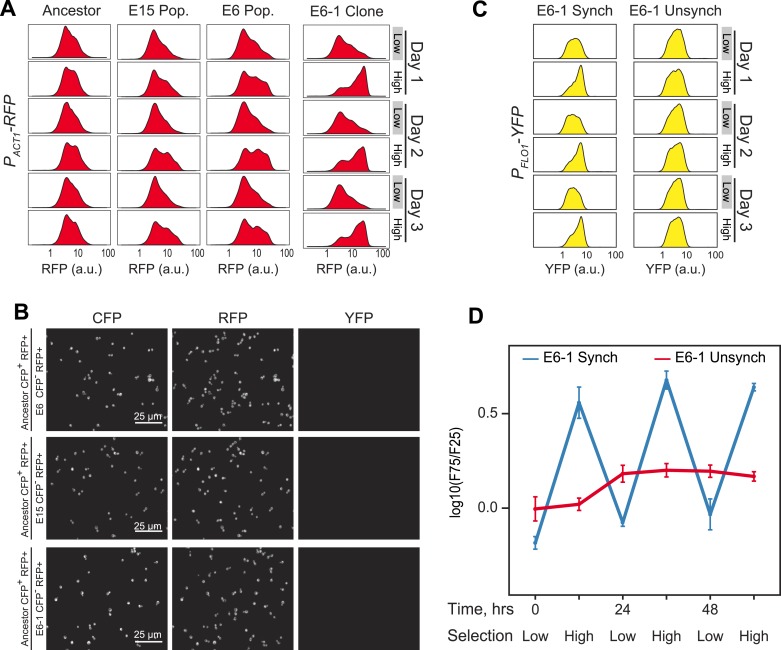
Evolution of 24-hr cell aggregation clock.(A) Representative density plots showing RFP oscillations of a FACS-synchronized sample of the final E6/E15 populations and a clone isolated from E6 (E6-1). (B) Ancestor cells expressing cerulean fluorescent protein (CFP+) were mixed with the populations E6, E15 and the clone E6-1 (none of which expressed CFP, (CFP−)), sonicated to single cells, and imaged. There are no detectable changes in YFP or RFP levels, per cell, between ancestral and evolved populations. YFP cannot be detected by microscopy in any strain. (C) Representative YFP density plots of E6-1 cells either synchronized by FACS (synch) or passaged through the FACS by collecting cells from the entire YFP distribution (unsynch) at identical 10 and 14-hr intervals for 3 days. (D) Oscillations were quantified by calculating the log(F75/F25) ratio of synchronized and unsynchronized cultures of E6-1. See Figure 3A for a definition of the F75:F25 ratio.